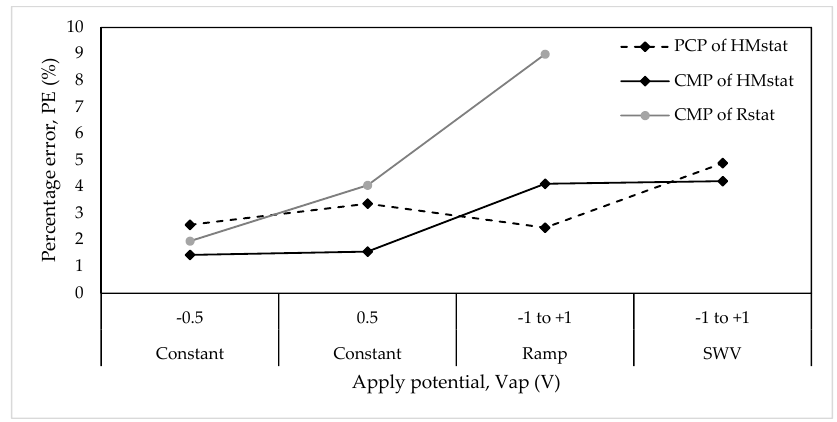
Figure 5. Accuracy of the current measurement part (CMP) for HMstat and Rstat.